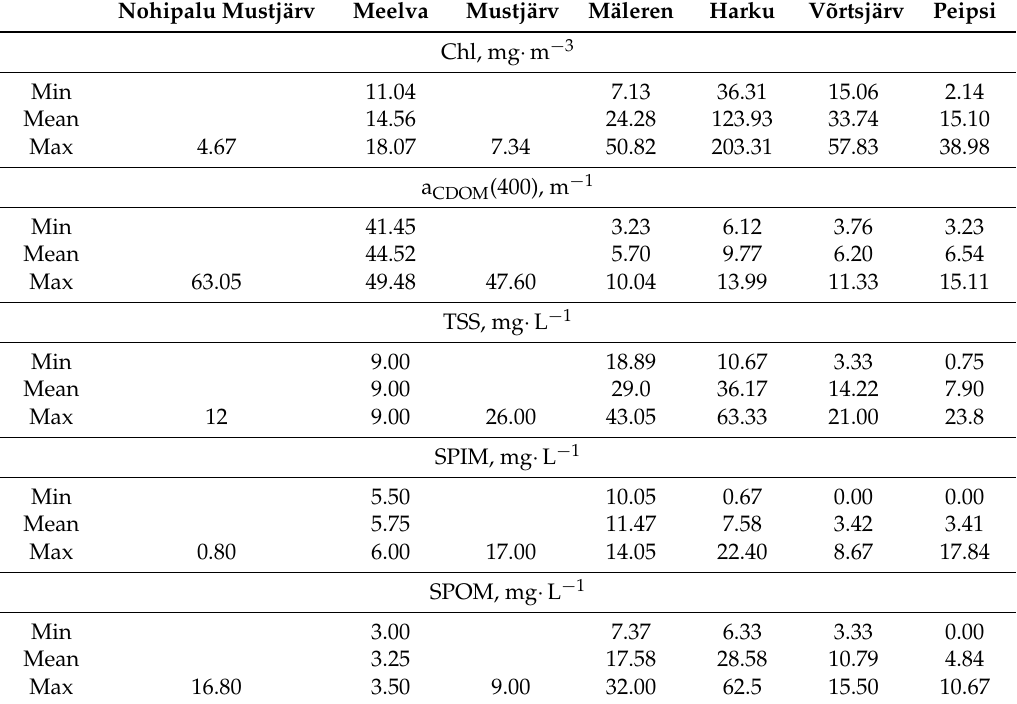
Table 1. Minimum, maximum, and mean concentrations of optically active substances measured in lakes under investigation. Concentration of Chl is in mg ¨ m ´ 3 , TSS, SPIM, and SPOM in mg ¨ L ´ 1 and a CDOM (400) in m ´ 1 . Only maximum values are provided if there is a single measurement from a particular lake. Nohipalu Mustjärv Meelva